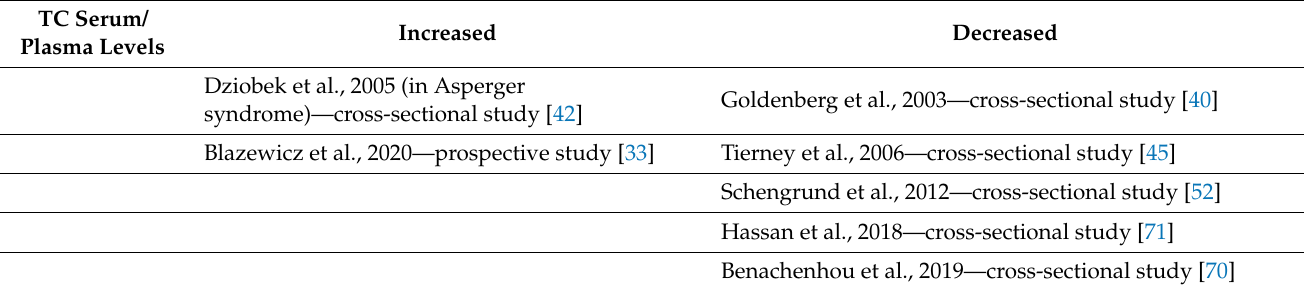
Table 2. Associations between serum/plasma total cholesterol (TC) levels and Autism spectrum disorders. TC Serum/ Increased Decreased Plasma Levels Dziobek et al., 2005 (in